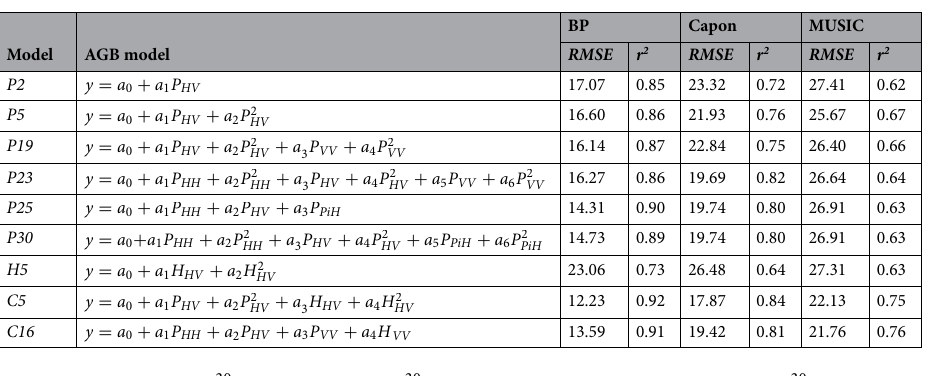
Table 3. Summary of P 30 , TFH, integrated P 30 at different polarization and integrated P 30 and TFH AGB